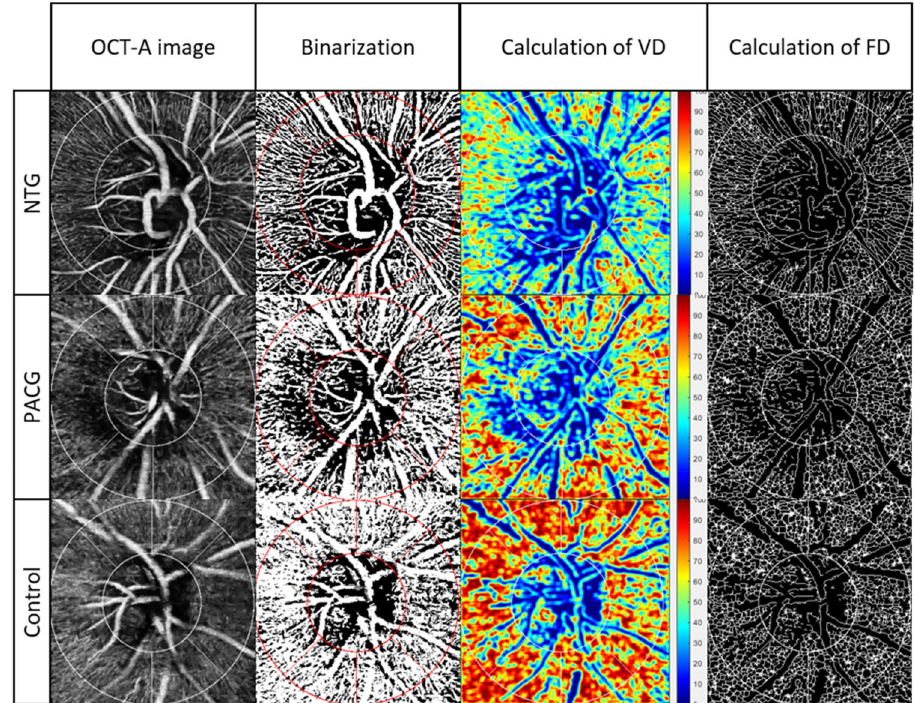
Figure 1. Quantification of peripapillary microvasculature from OCT-A images in NTG, PACG and normal control subjects. A series of OCT-A metrics, including circumpapillary vessel density (cpVD) and fractal dimension (cpFD) were automatically calculated after large retinal vessels removal by our customized MATLAB (MathWorks, Natick, MA)